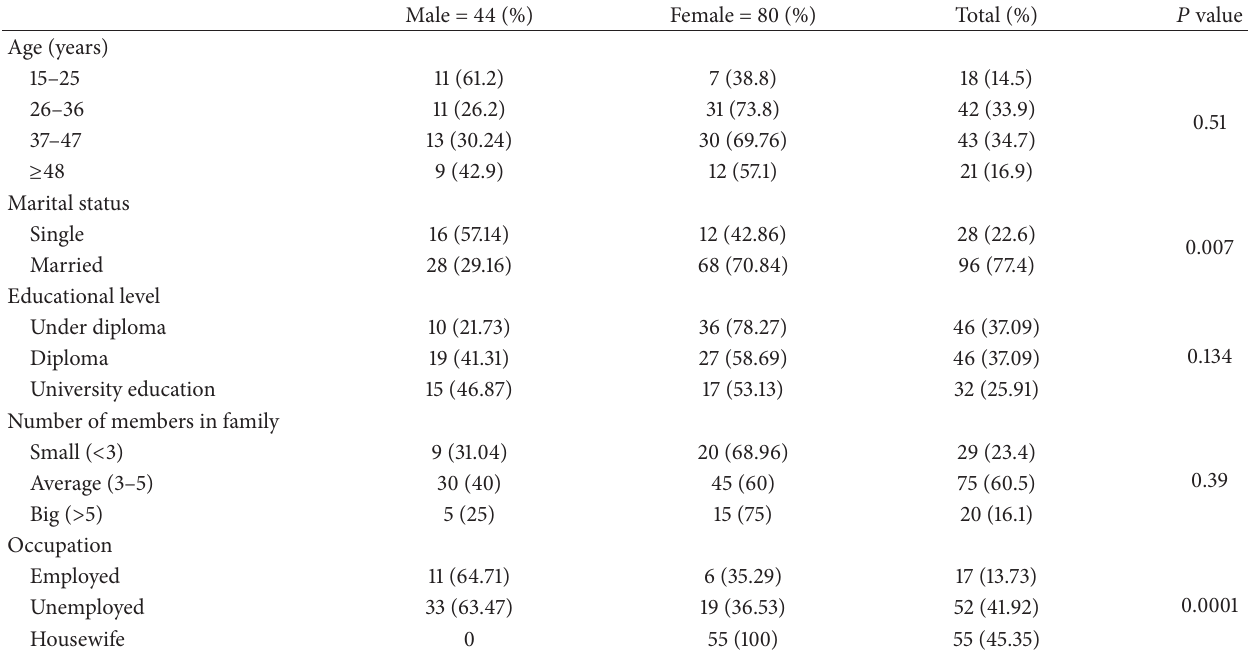
Table 1: Demographic characteristics of the respondents ( 𝑛 = 124 ).